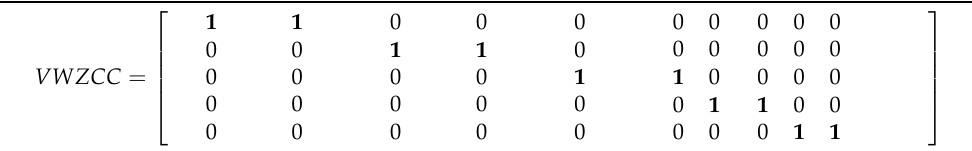
Table 2. 1D-VWZCC when K = 5 and W =